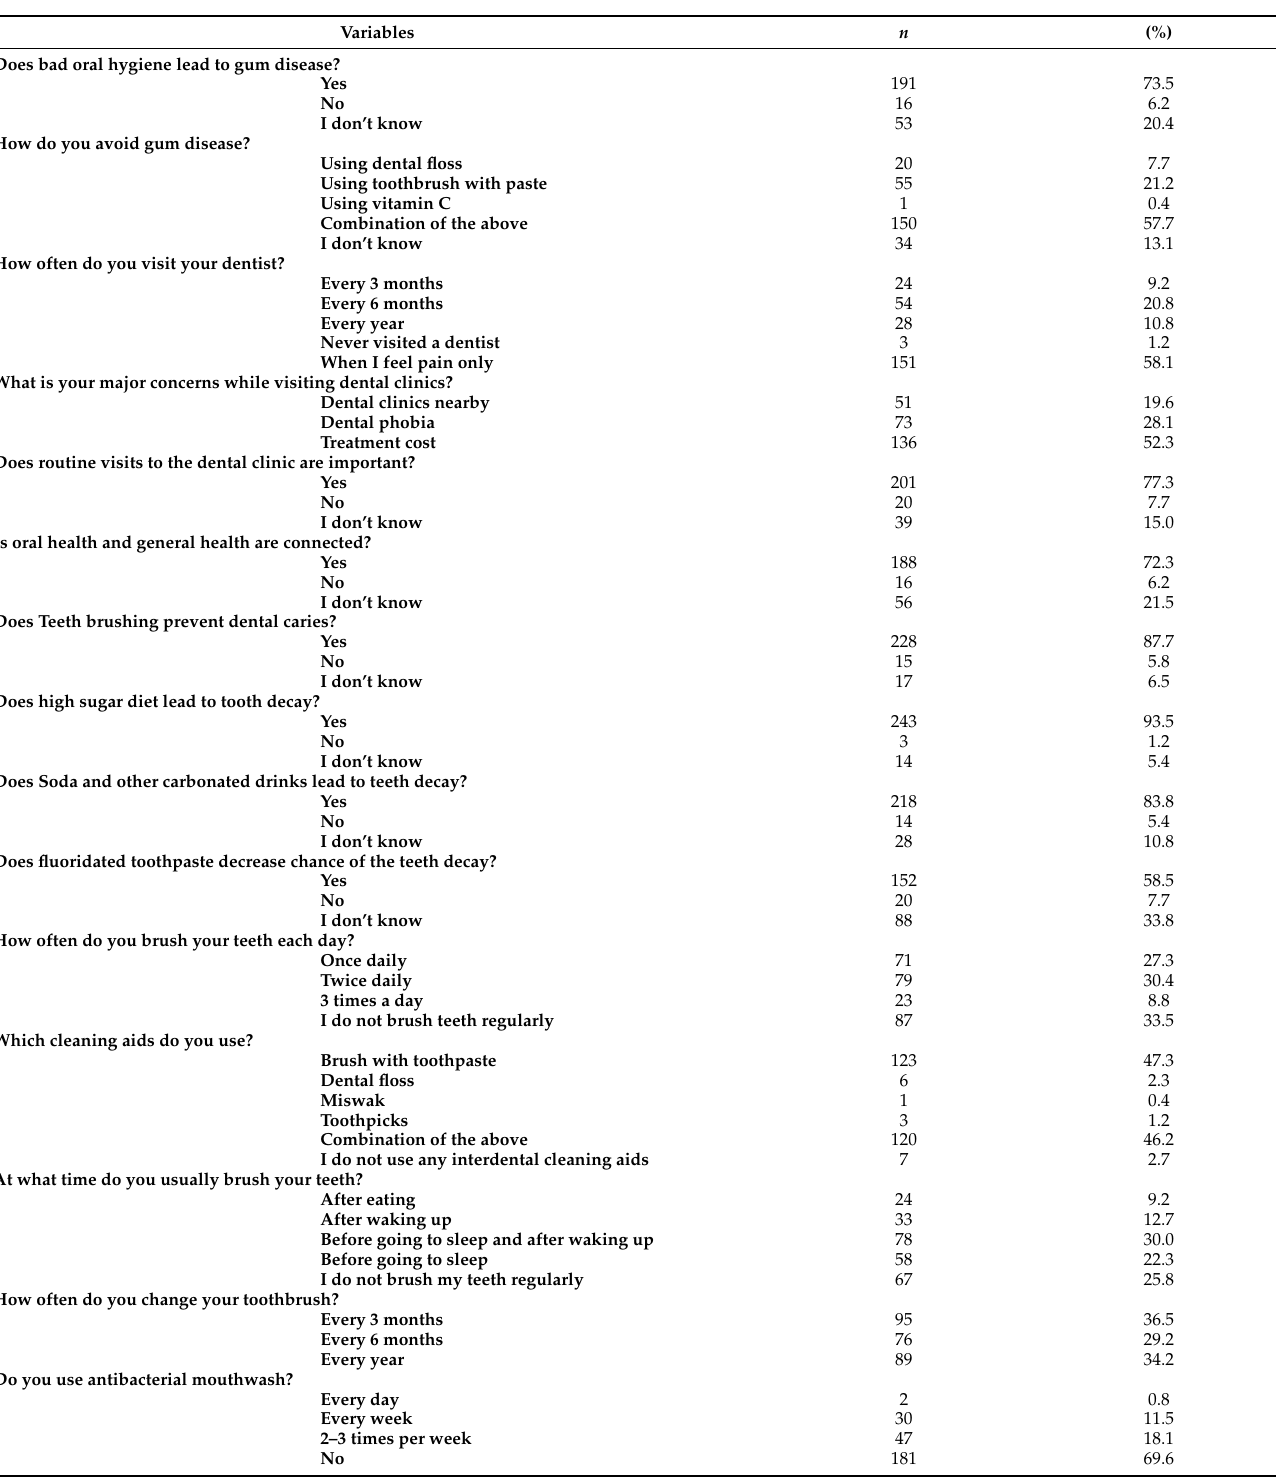
Table 2. Prevalence of knowledge, attitude and practices towards oral health maintenance of study